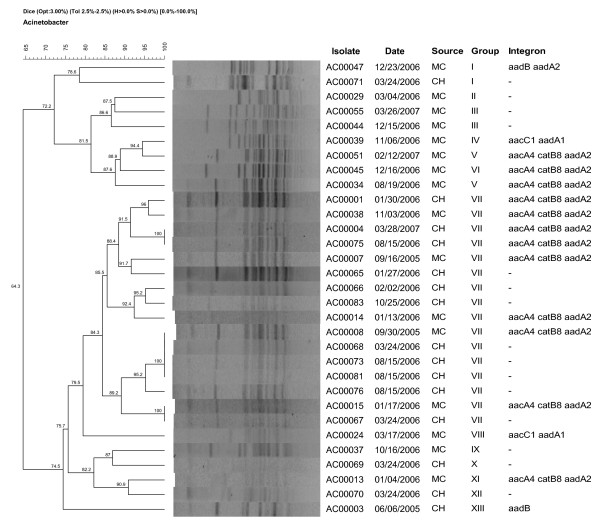
PFGE profiles of selected strains. A. baumannii isolates representing various resistance profiles from different hospitals and different units were genotyped. Figure is the representation of PFGE fingerprints of thirty one selected isolates. Thirteen genotypes (Group I to XIII) were identified in this study. The percentage of similarities was determined by the Dice's coefficient and UPGMA clustering. Major clusters were formed at the 75% similarity level. * Source abbreviations are MC (Ohio State University Medical Center) and CH (All central Ohio isolates derived from the State Public Health laboratory). The various ICUs in MC include Ross Heart hospital, James Cancer Hospital, Rhodes and Doans hospital and the Emergency Department.